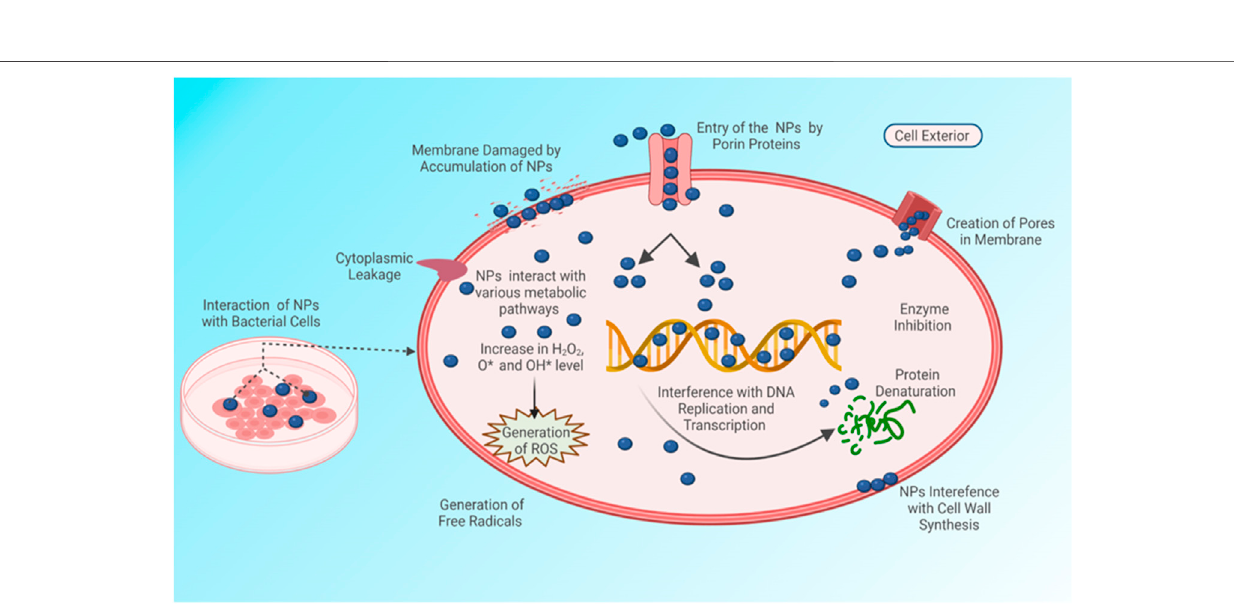
inhibition of 63.50 ± 2.50% on the Gram-positive bacterium E . faecalis compared with the Gram-negative bacterium S.